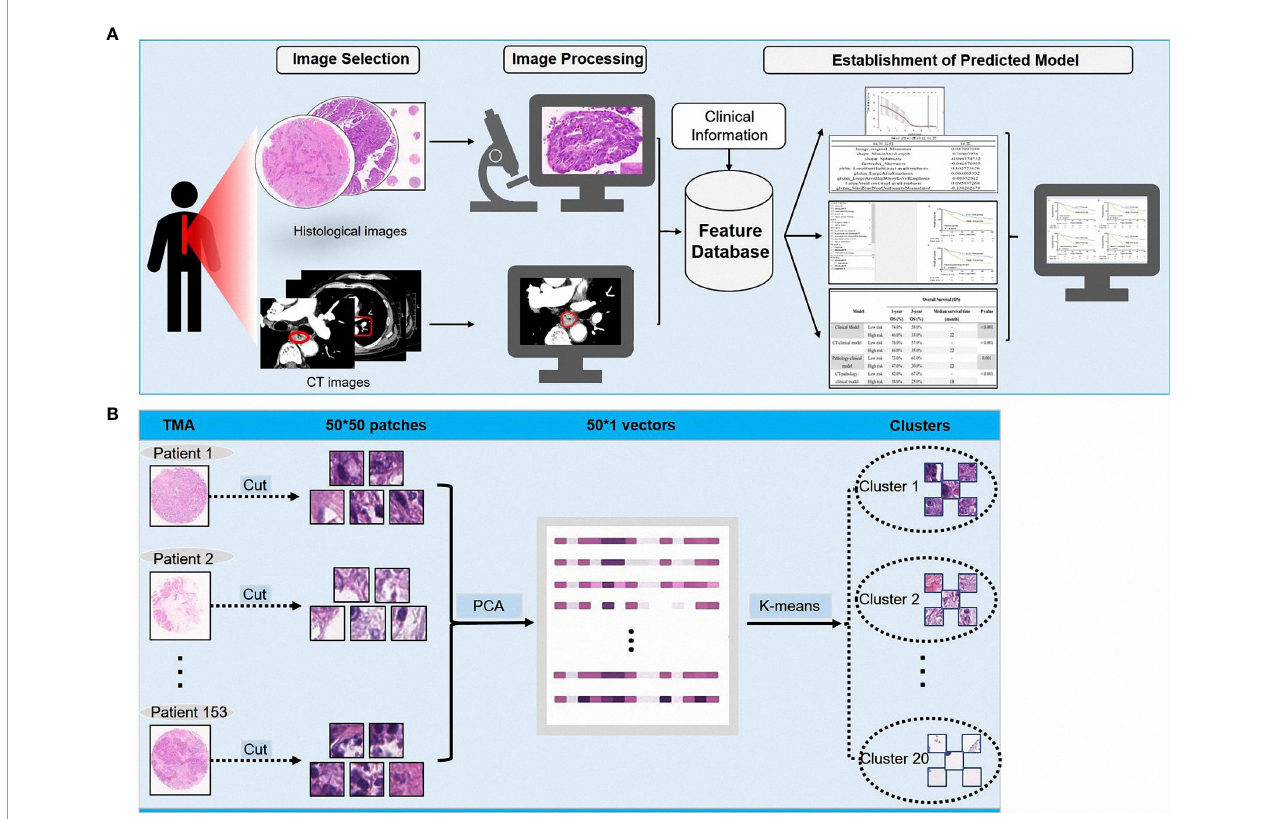
FIGURE 1 | (A) The schematic diagram showing the study design; (B) The processing of pathological